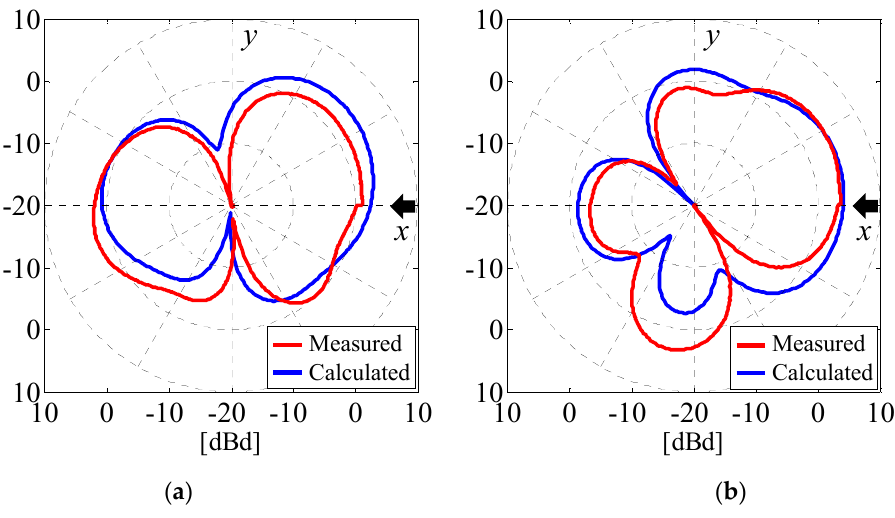
Figure 20. Measured and calculated results of radiation patterns. ( a ) Subarray1. ( b ) Subarray2.